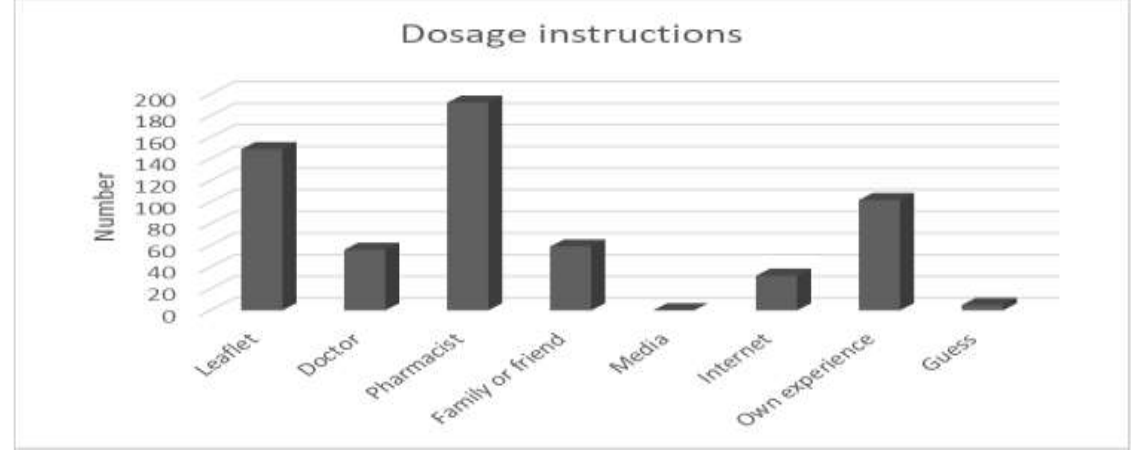
Figure 4. Source of dosage instructions .